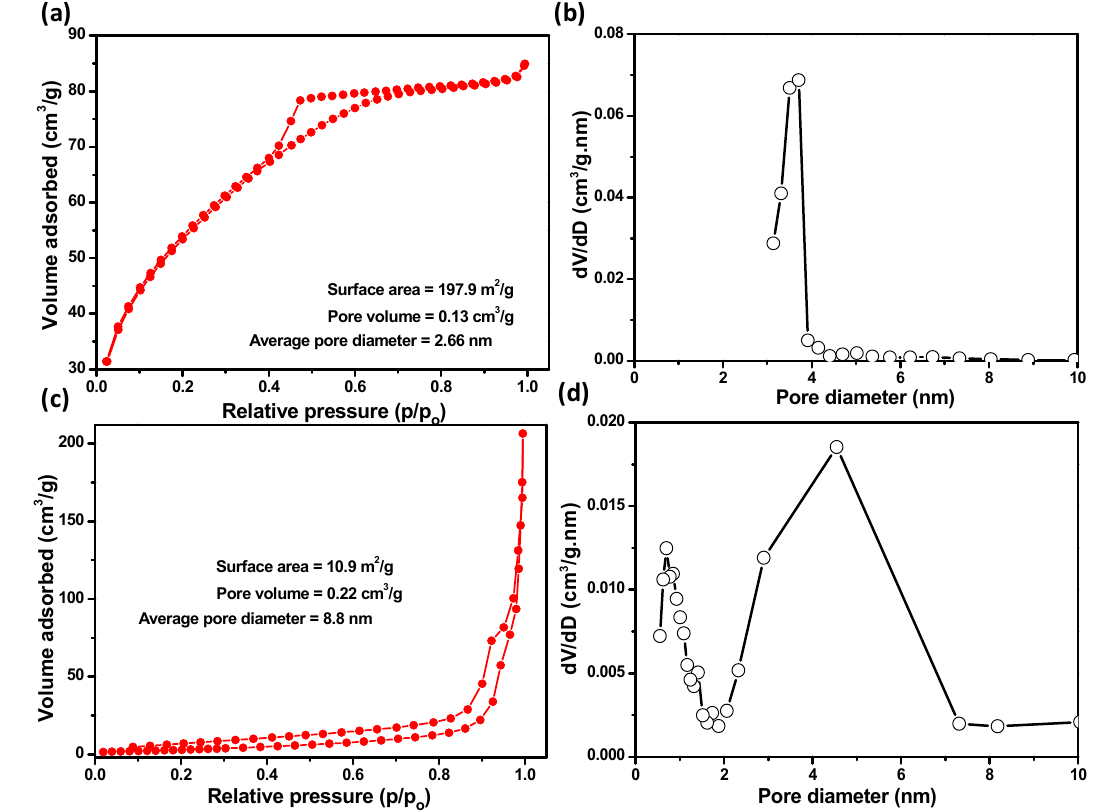
Figure 5. Multipoint BET nitrogen adsorption–desorption isotherms of ( a ) SS and ( c ) LS samples, and pore size distribution curves of ( b ) SS and ( d ) LS samples, calculated from the desorption branch of the isotherm.